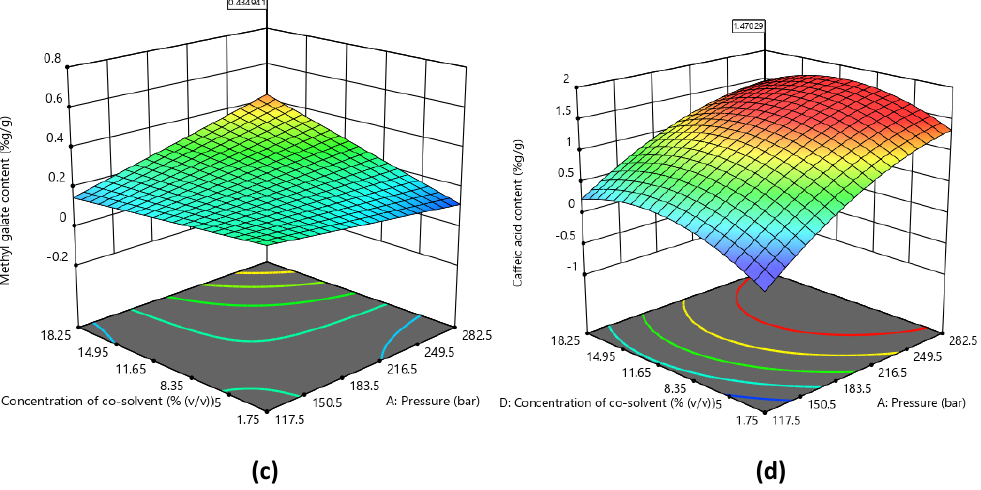
Figure 3 a-d Figure 3. Effect of pressure and concentration of co-solvent on ( a ) extraction yield, ( b ) gallic acid content, ( c ) methyl gallate content, and ( d ) caffeic acid